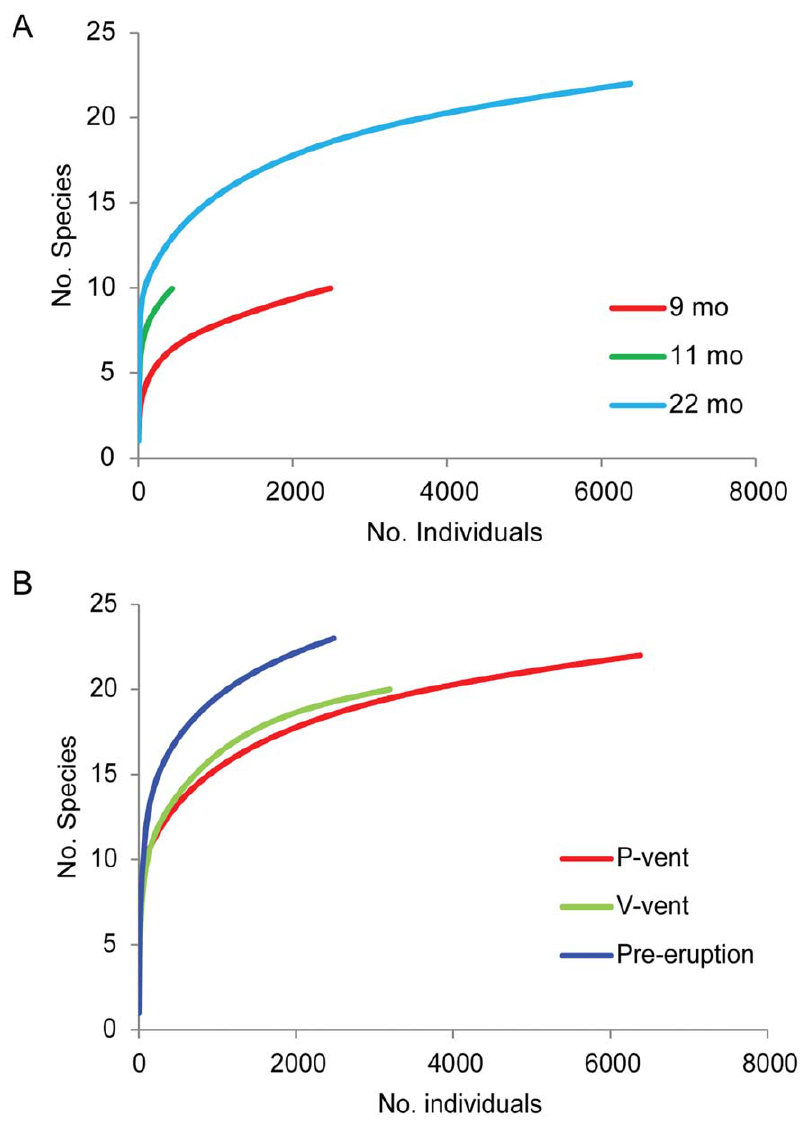
Figure 5. Species diversity as a function of number of individuals from rarefaction analysis. Curves are pooled over three replicates for each recovery date (9, 11 and 22 months after the eruption) in the analysis of Time (A) and for each disturbance history (disturbed at P-vent, undisturbed at V-vent and undisturbed Pre-eruption) in analysis of Disturbance (B).